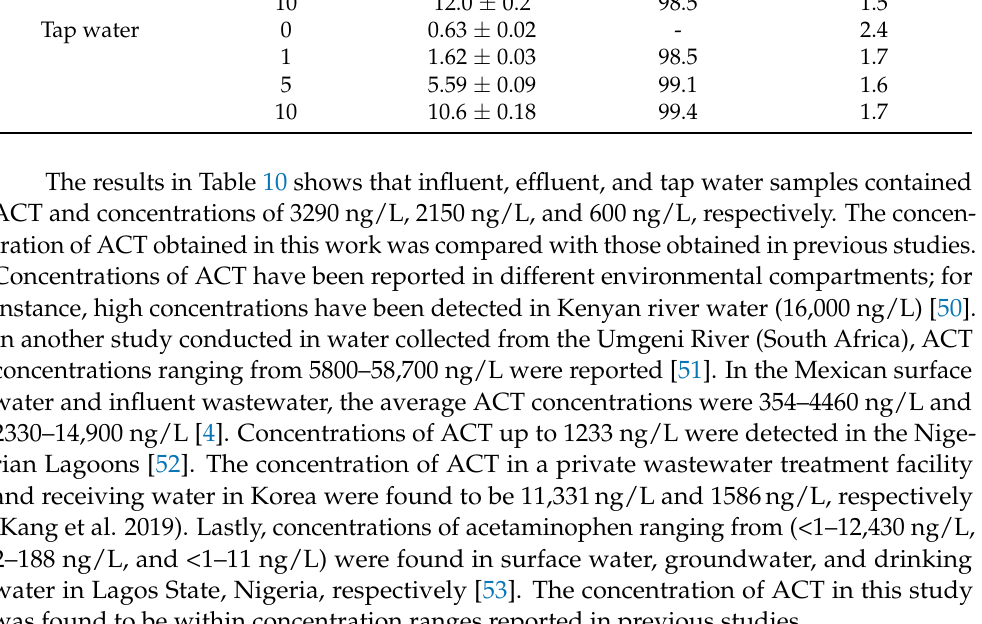
(c) Dubinin–Radushkevich., Figure S2: Isotherms models (a) Sips and (b)